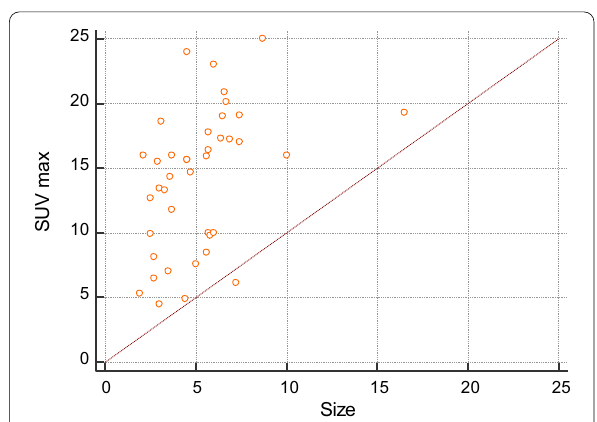
Fig. 5 Scatter diagram displaying the positive correlation between tumor max.SUV and tumor size in all patients